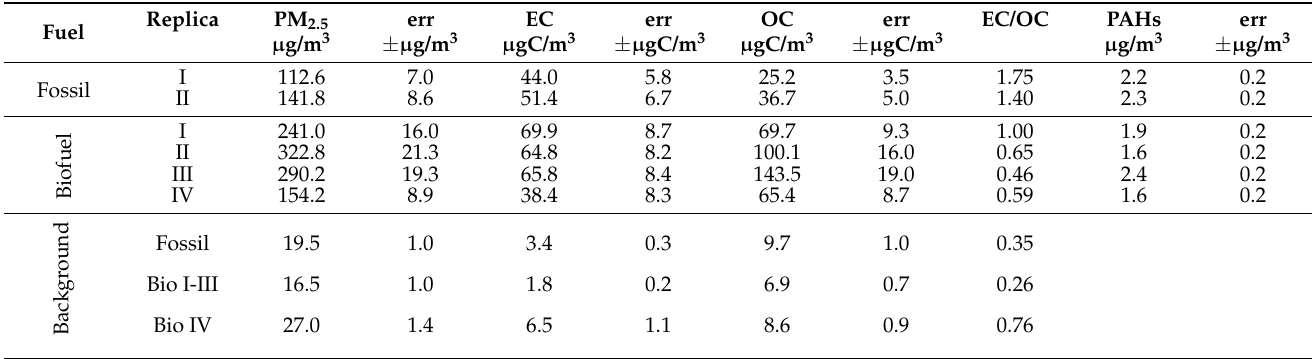
Table A6. Concentrations of total PM 2.5 , EC, OC, and total measured PAHs in filters sampled during the different replica. Data are reported as average and the relative error.